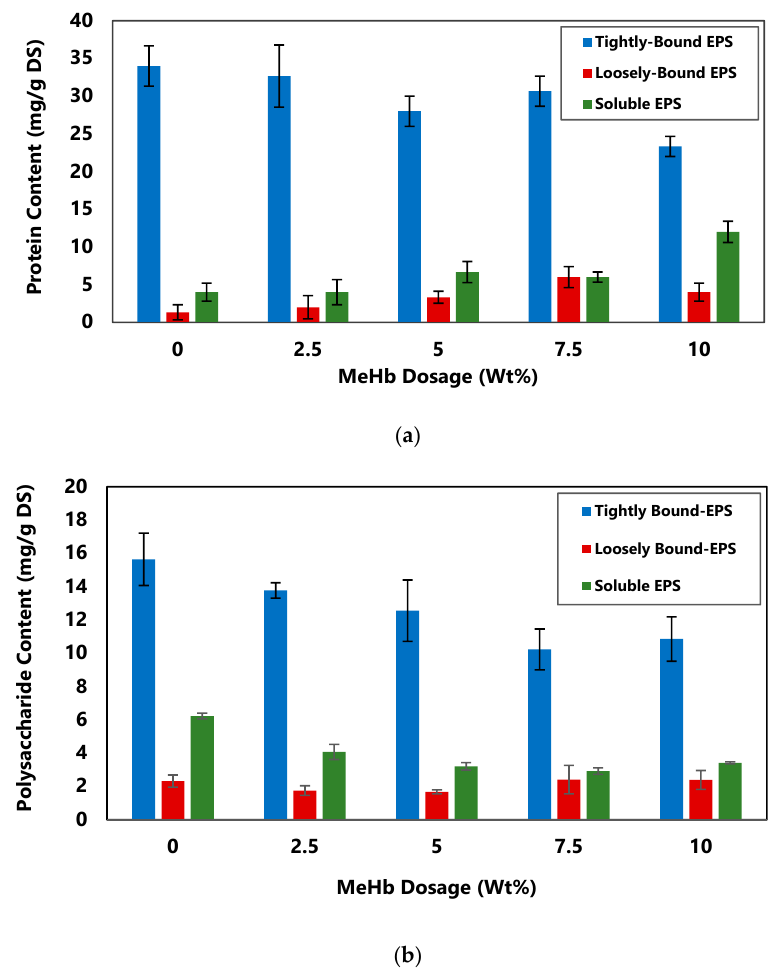
Figure 6. ( a ) Protein content and ( b ) polysaccharide content of EPS in biosludge at di ff erent dosage of methylated